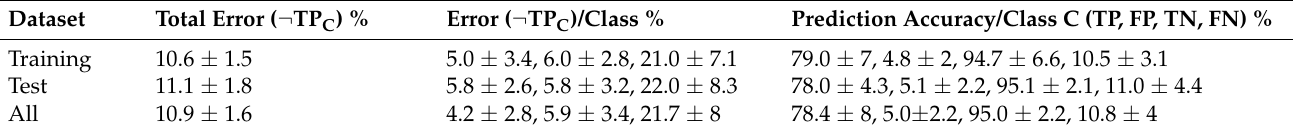
Table 1. Accumulated prediction results for the training and test data and the entire dataset combined, with statistical features of the model ensemble trained in parallel (using different data sub-sets and random initialisation). All errors have a 2 σ standard deviation interval, and N = 9000 samples, n = 3000 for each class, using CNN architecture A.